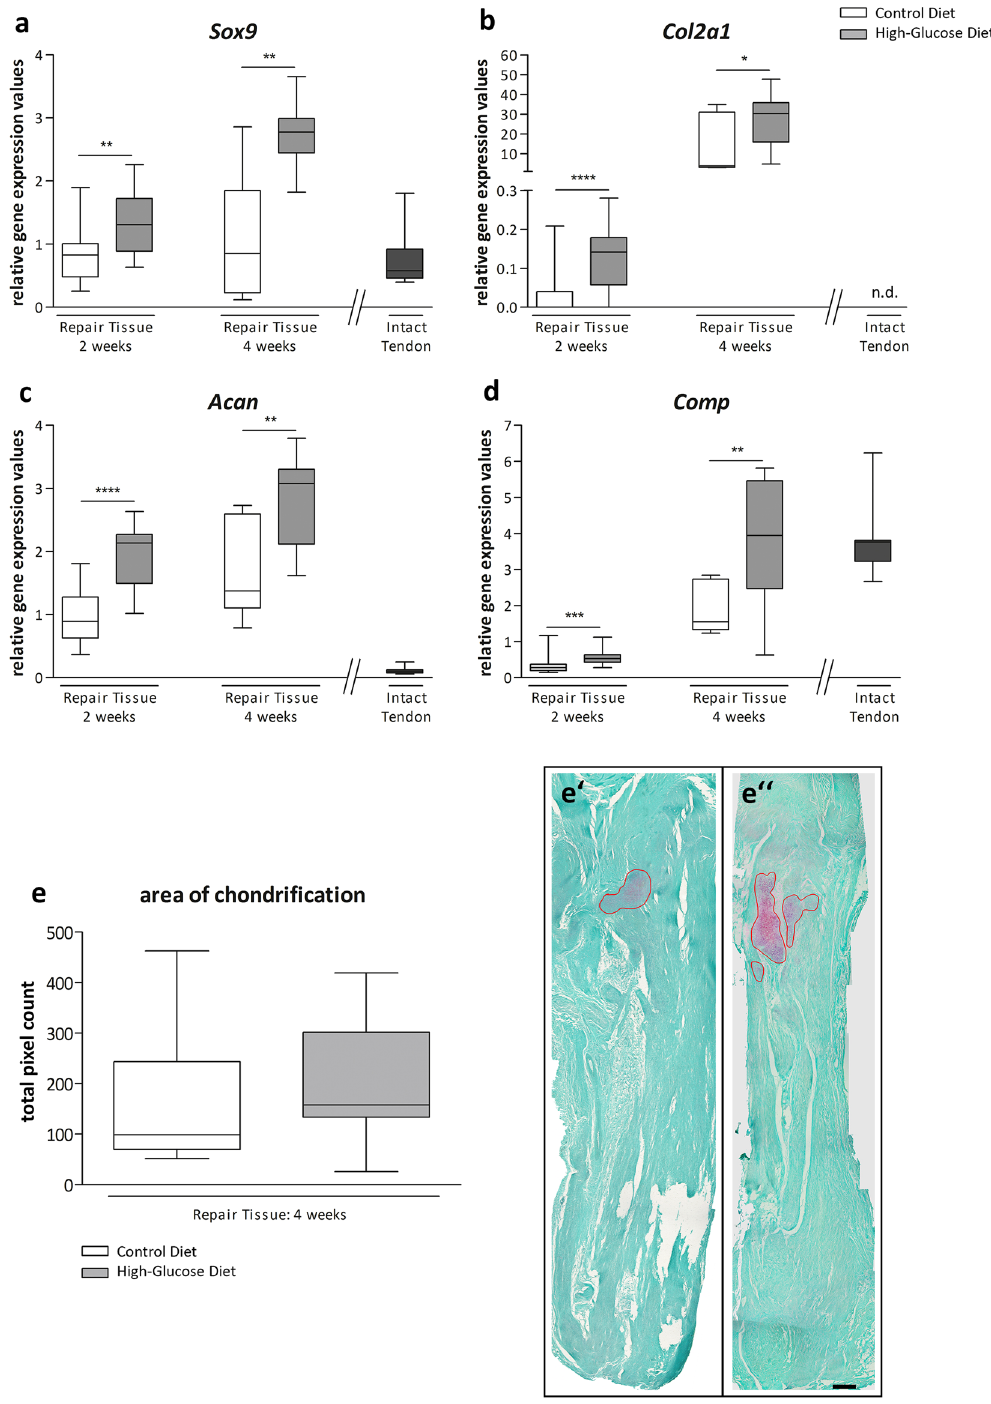
Figure 7. Gene expression analysis and histomorphometry of tendon repair tissues. Quantitative PCR analysis of tendon repair tissues shows that the chondrocyte lineage-associated genes Sox9 ( a ), Col2a1 ( b ), Acan ( c ) and Comp ( d ) are significantly upregulated in animals receiving a high-glucose diet for 2 and 4 weeks, respectively, compared to animals fed a control diet (Mann-Whitney test, two-tailed). Values for intact tendons are provided as a reference. Quantification of areas showing beginning chondrification 4 weeks after surgery did show a trend of increasing chondrification in the high-glucose group ( e ), though the difference was not significant (p = 0,328; Mann-Whitney test, two-tailed). Representative Safranin O & Fast green stained sections of the control diet group (e’) and the high-glucose diet group 4 weeks post op. (e”). Scale bar: 500 µ